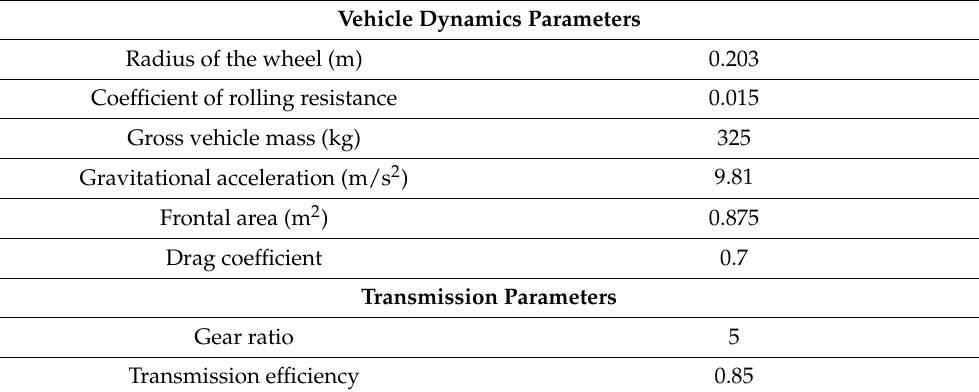
Table 2. Model input: the inputs used to define the characteristics of the car.